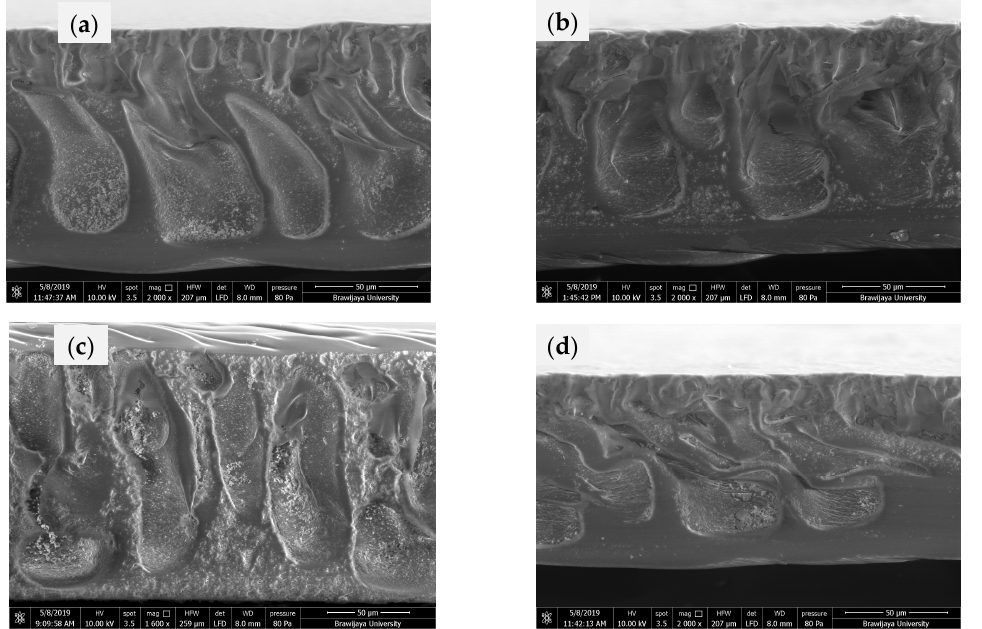
Figure 4. Cross-sectional membrane sheets observed by SEM (2000 × magnification): ( a ) Pristine CA membrane (DMAc); ( b ) 1.0wt% CPHE/CA composite membrane (DMAc); ( c ) Pristine CA membrane (DMF); and ( d ) 1.0wt% CPHE/CA composite membrane (DMF).